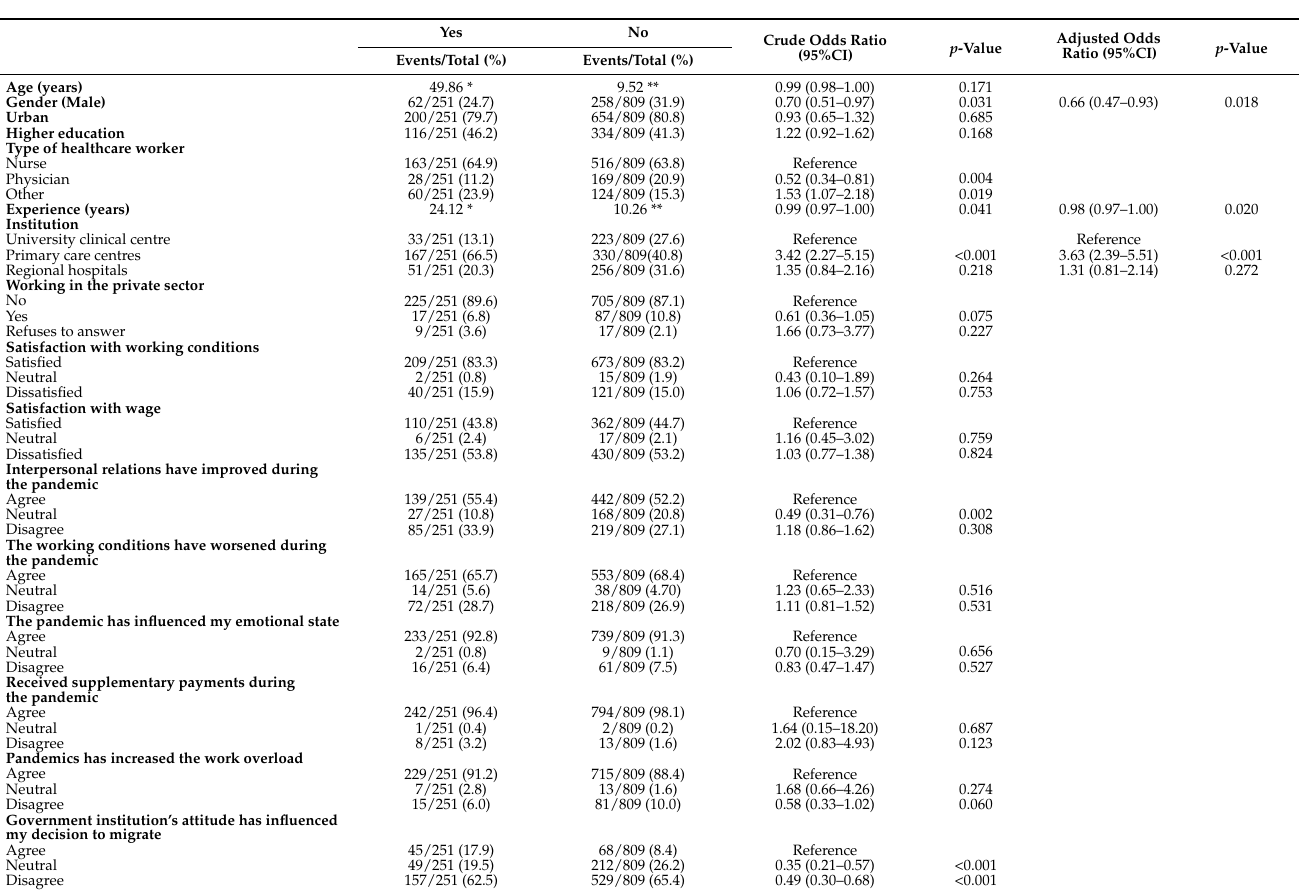
Table 4. Preference for migration